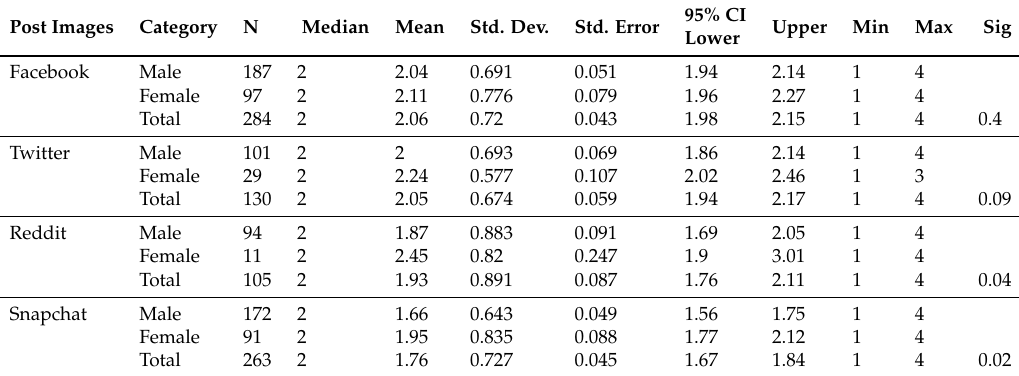
Table 17. Differences between sexes when posting things on social media.